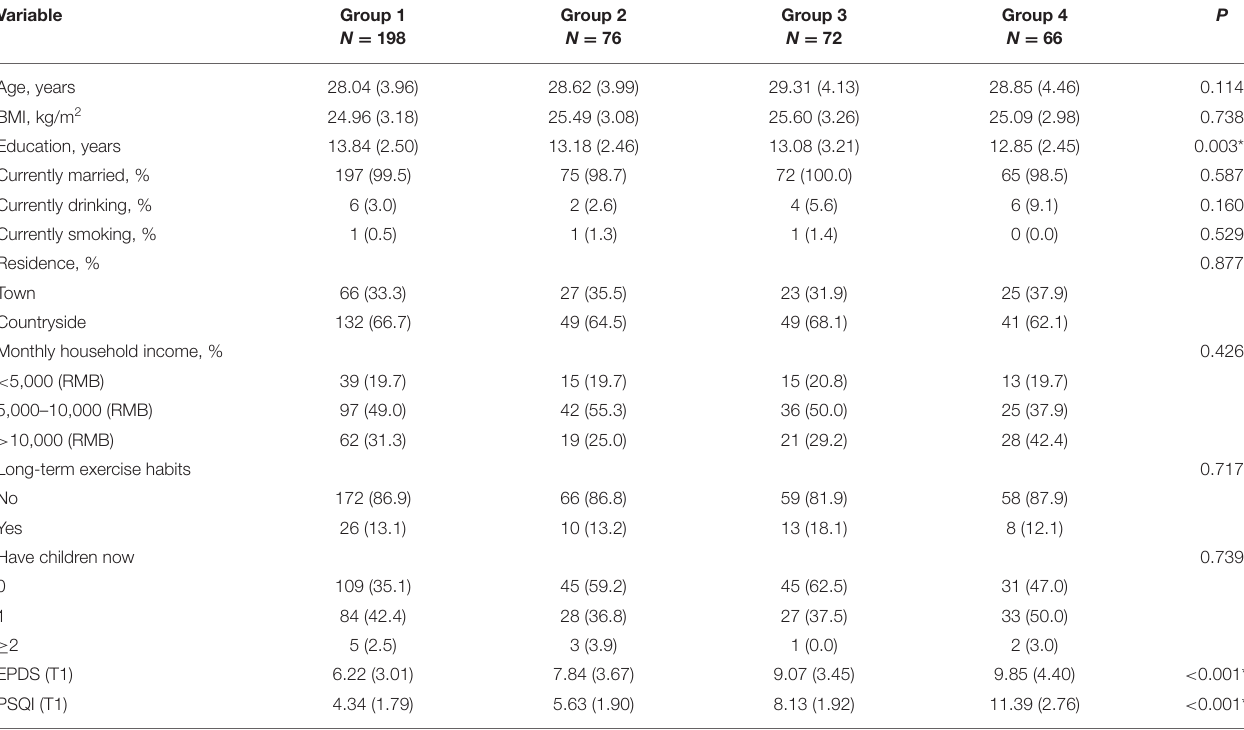
TABLE 2 | Differences in baseline characteristics among sleep trajectory